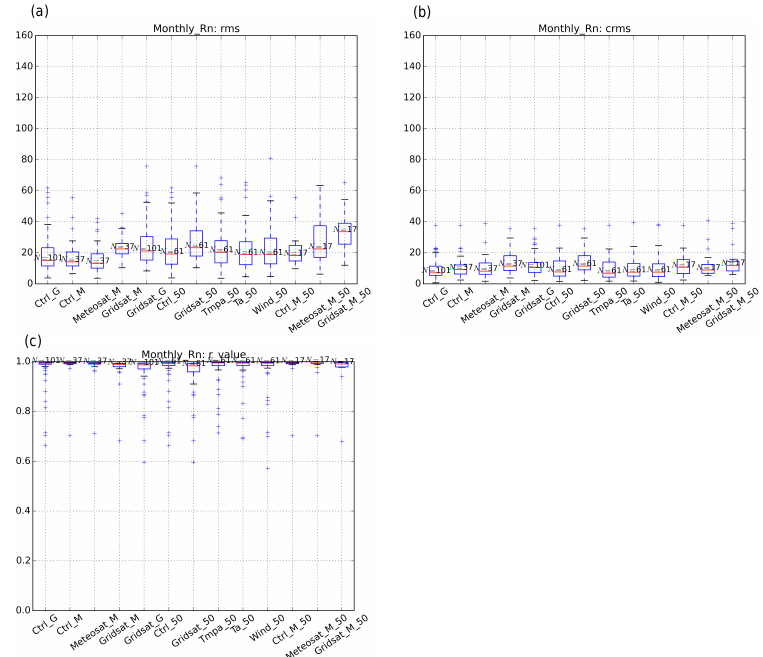
Figure D2. Similar error statistic for R N like Fig. 5 but for monthly timescales: (a) RMSD, (b) cRMSD, (c) correlation coefficient.